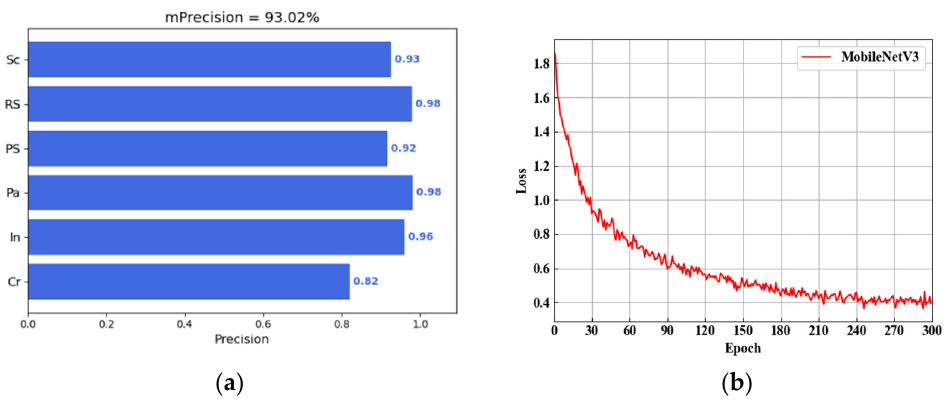
Figure 15. Classi fi cation precision and loss curves. ( a ) Precision. ( b ) Loss curve. Figure 15. Classification precision and loss curves. ( a ) Precision. ( b ) Loss